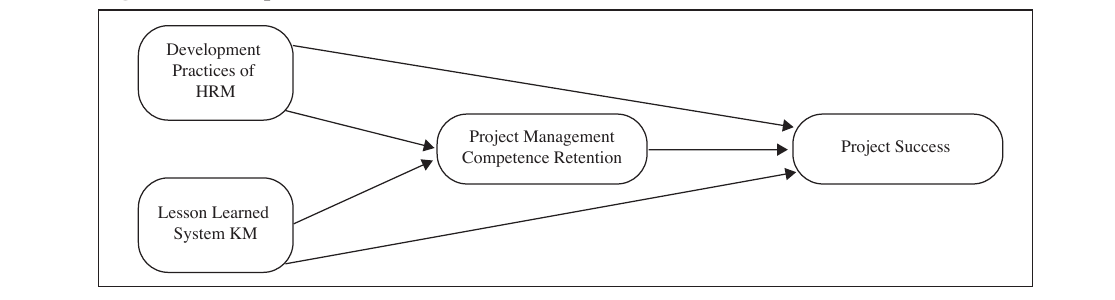
Figure 1 : Conceptual